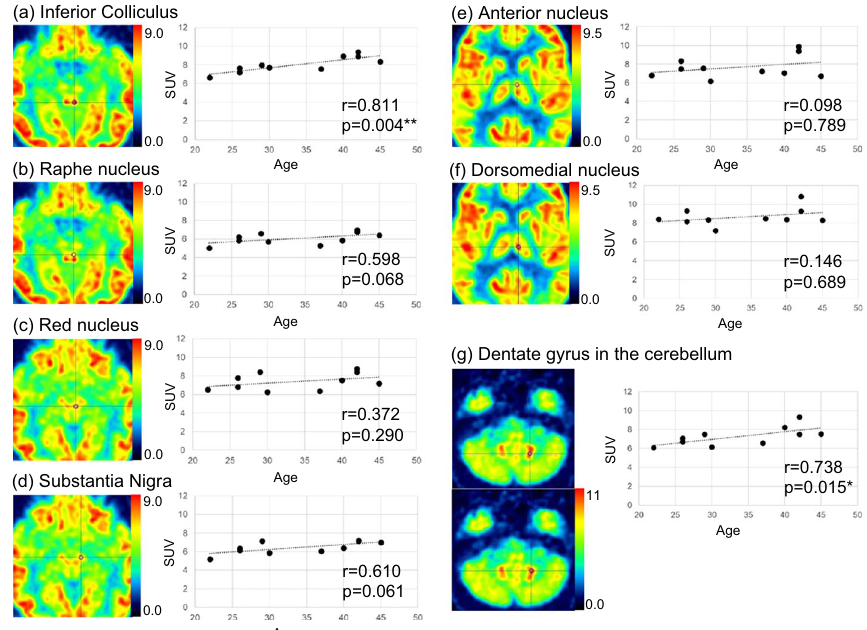
Fig. 5 Representative images of 4-mm-diameter volume-of-interest (VOI) manually placed on each structure. The plots of the averaged standardised uptake values (SUV) of these right- and the left-side VOIs and ages are presented with the images